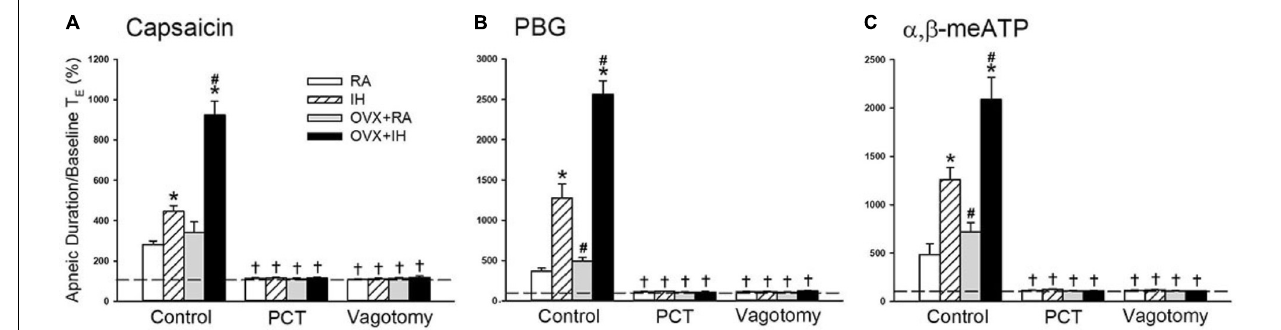
FIGURE 2 | Role of lung vagal C fibers in IH-induced augmented apneic responses to stimulants in female rats. Groups of intact rats were exposed to RA or IH for 14 days, and OVX rats were exposed to RA (OVX + RA) or IH (OVX + IH) for the same duration. Each rat’s apneic responses to intravenous capsaicin (A) , PBG (B) , and α , β -meATP (C) were measured under control conditions, after perivagal capsaicin treatment (PCT; 250 µ g/ml), and after vagotomy. Apneic duration indicates the longest expiratory duration (TE) during the first 20 s after stimulant injection. Baseline TE was calculated as the average over 10 consecutive breaths immediately before injection. The horizontal dashed lines indicate the apneic ratio of 100% (no response). ∗ p < 0.05 compared with responses of RA rats under the same experimental condition; # p < 0.05 compared with responses of IH rats; † p < 0.05 compared with control responses in the same group. Except for the RA group, which included rats in the four stages of the estrus cycle ( n = 6/each stage; total number of RA rats: 24), all data from the other groups are presented as means ± SE of 10 rats. See the legend of Figure 1 for further explanation.